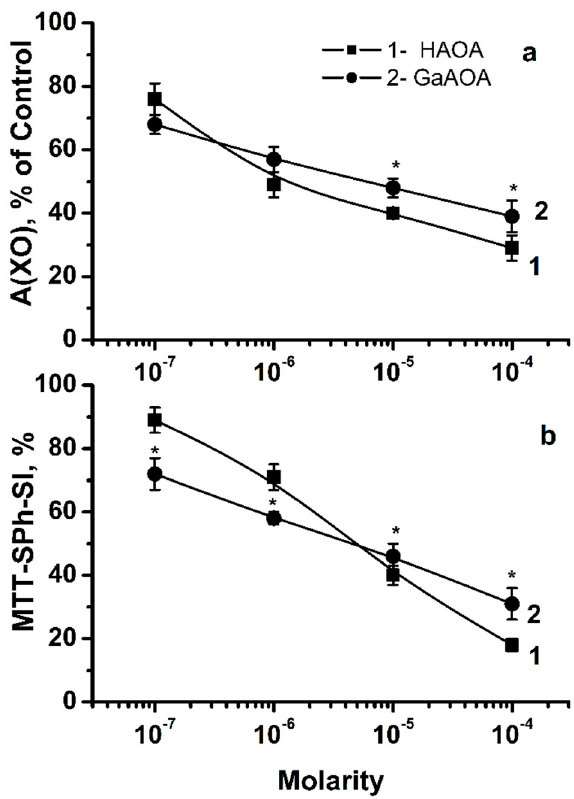
Figure 4. Effect of HAOA (curve 1) and GaAOA (curve 2) on ( a ) the activity of xanthine oxidase and ( b ) total free radicals’ formation in rat blood serum. Data = mean ± SD ( n = 5). *, statistically significant difference from HAOA ( p < 0.05).